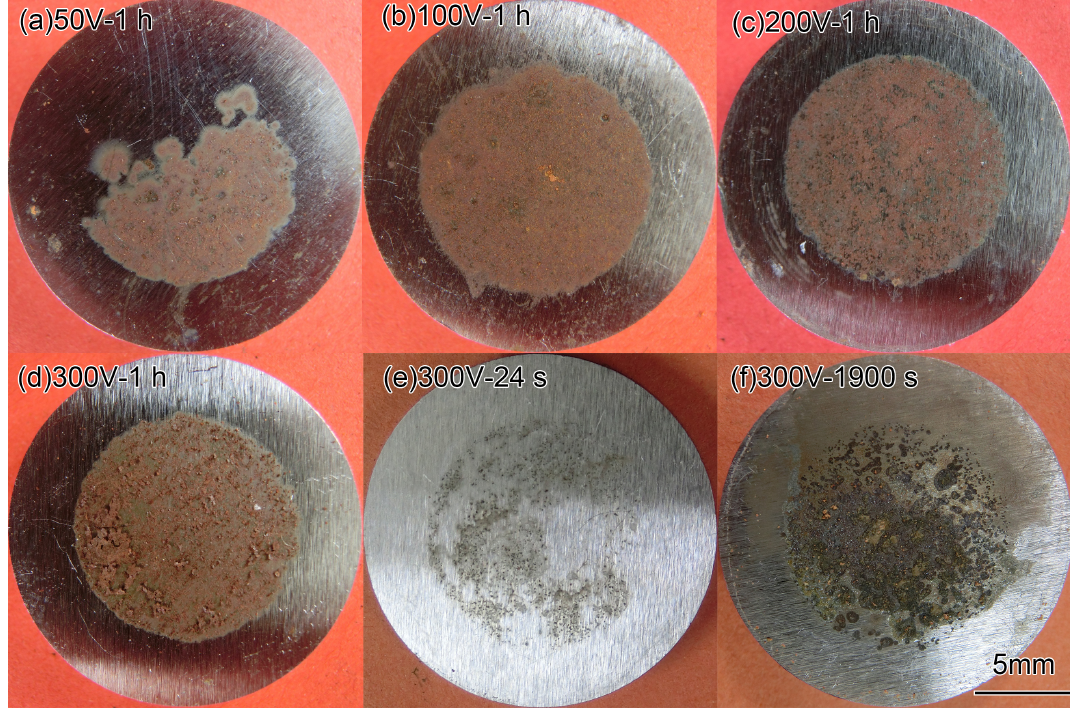
Figure 7. Macro morphologies of X80 steel coupons after HVDC